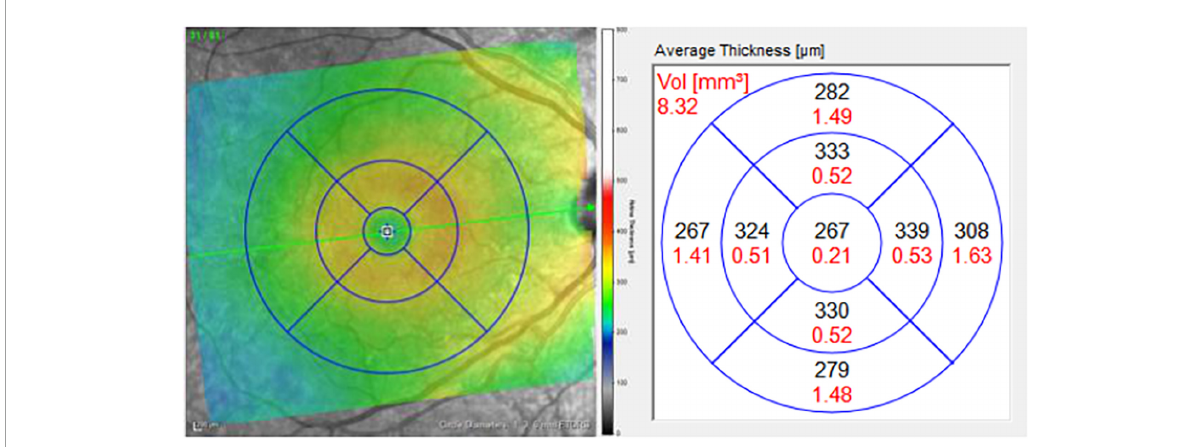
FIGURE1 Macular grid with 1, 3, and 6 mm diameter circles centered on the foveola (left) . Measurements for average thickness (black) in areas of each sector of the macula (right) . Only the central five macular sectors were analyzed in this study: central macula, and the inner superior, inferior, nasal, and temporal sectors, bordered by the 3 mm diameter circle.